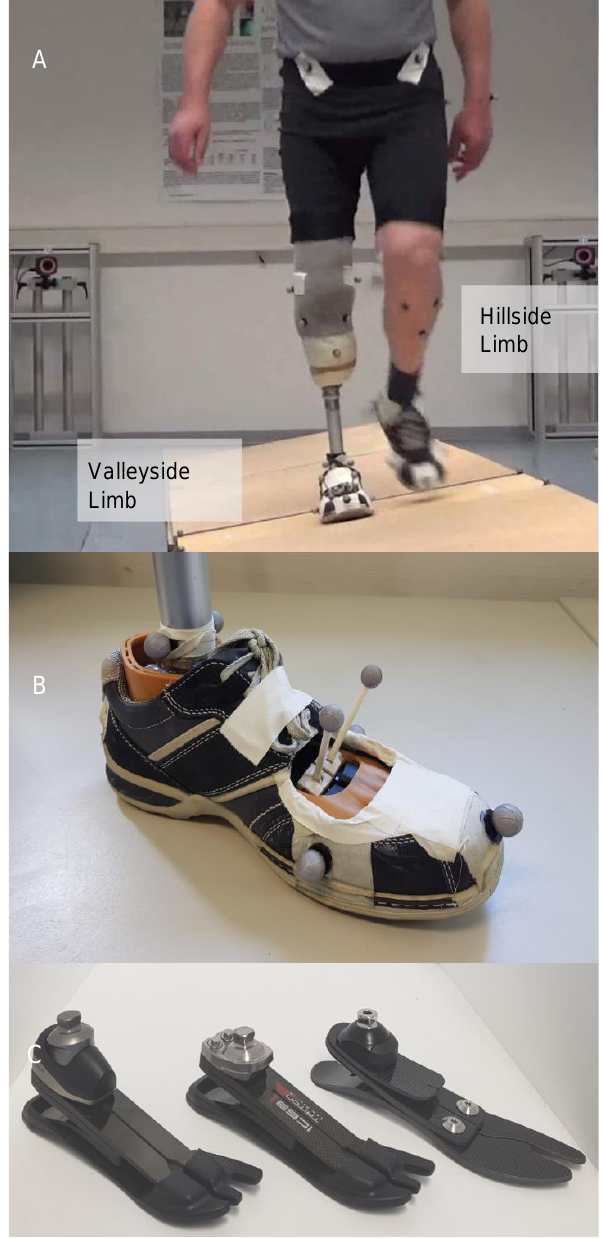
Figure 1: Experimental setup and prosthetic feet used. (A) shows the 8.5m cross-slope with a force plate embedded in the center of the track (shown step) and a typical participant (prosthesis is valleyside limb, intact side is hillside limb). (B) display the marker set for estimating the CoP (markers on toe and heel of shoe) and the adaptation to the tilt (shoe markers and antenna markers through a cutout in the shoe and foot shell, attached to the carbon base). (C) shows the prosthetic feet tested: Triton Side Flex (left), Triton LP (middle) and Pro-Flex LP